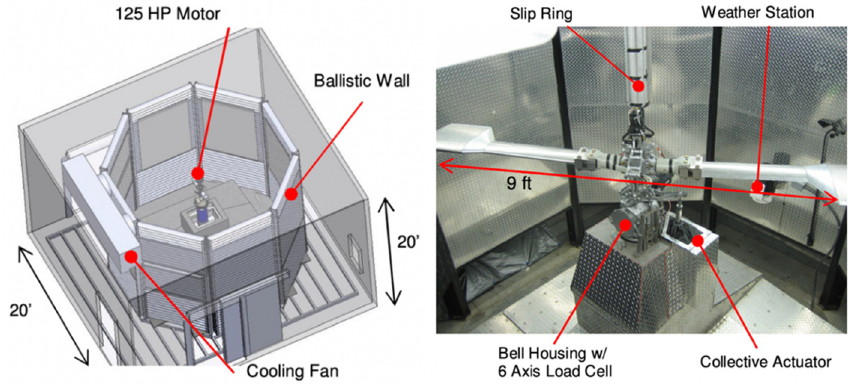
Figure 3. Overview of AERTS ( left ) and test stand ( right ) (Reproduced with permission from Palacios, J.L. [68]).